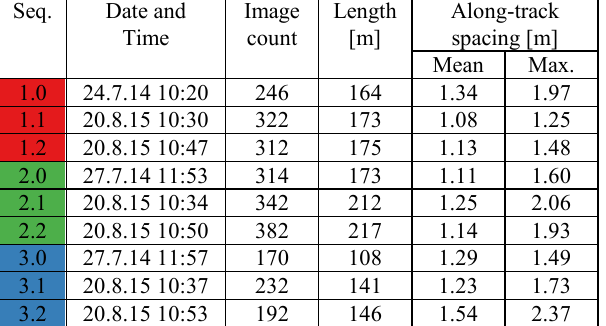
Table 1. Characteristics of the nine selected stereo image sequences x.y (where x corresponds to the street sections 1 to 3 shown in Figure 2 and y corresponds to the campaign, 0 = 24./27.7.2014, 1 = 20.8.2015 10:30-10:37, 2 = 20.8.2015 10:47-10:53)